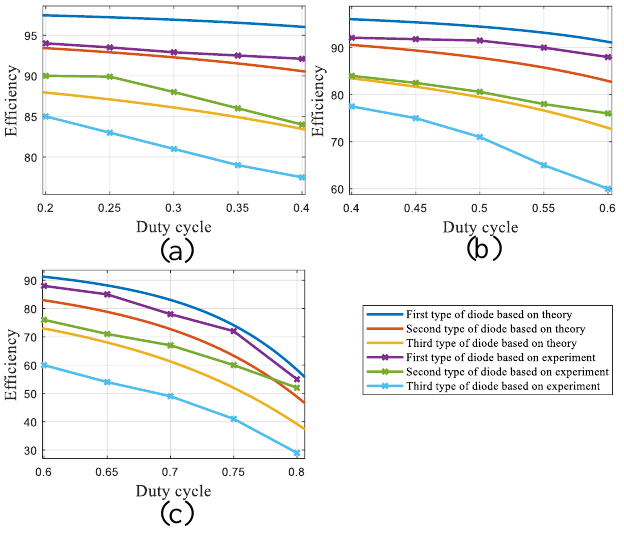
Figure 22. The efficiency comparison based on the theory and experimental results of the three various diode types while the duty cycle varies from ( a ) 0 to 33%, ( b ) 33% to 66%, and ( c ) 66% to